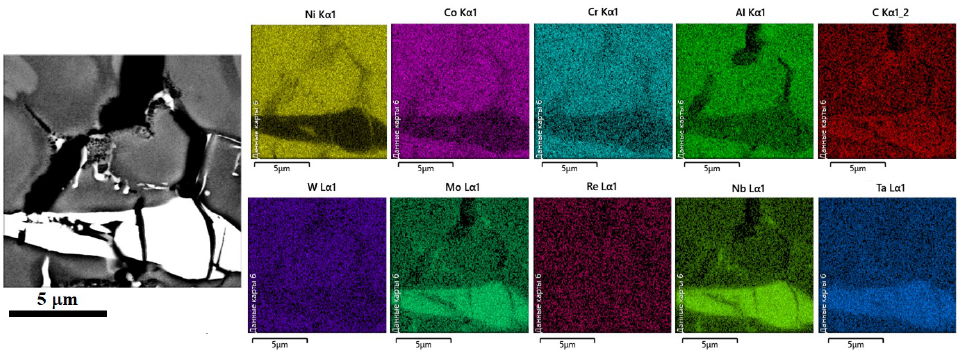
Figure 5. Distribution of elements in the area of